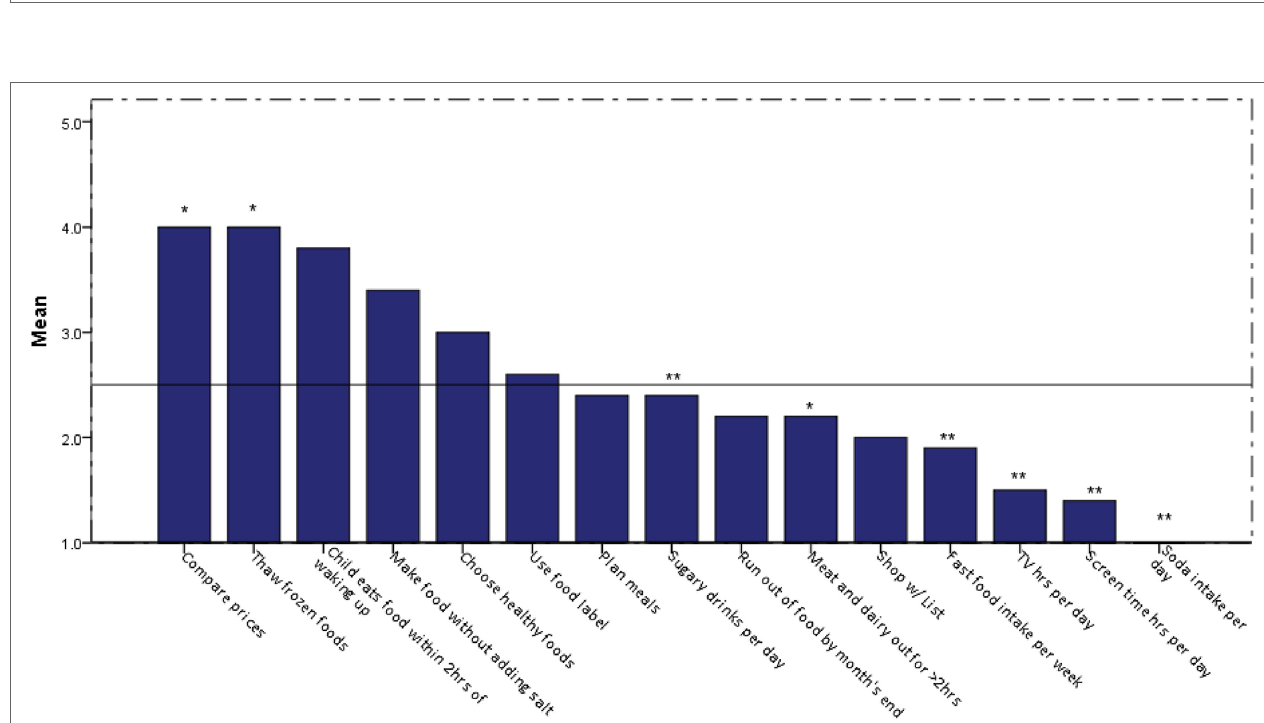
FigUre 1 | Shape-up and eat right families body mass index changes pre- and post-intervention (last observation carried forward).